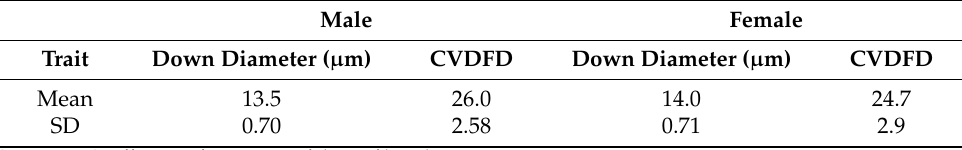
Table 3. Descriptive statistics for down fiber diameter and CVDFD in males and females